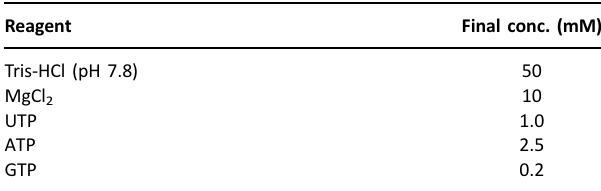
Table 2. Reagents for UPRT assay. Table 3. Reagents for CTPS